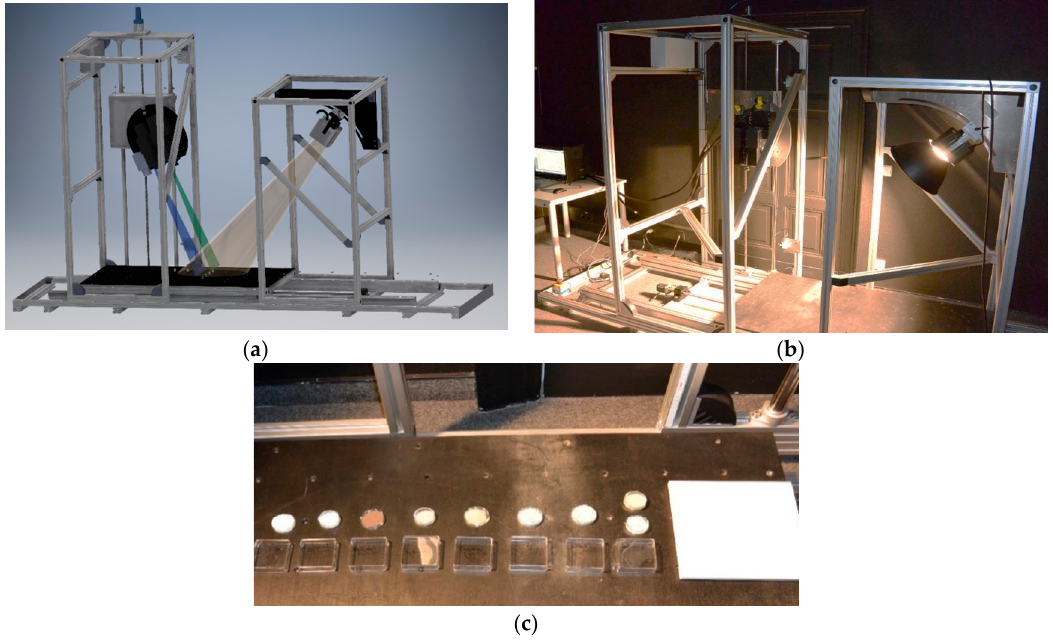
Figure 1. Translational imaging spectroscopy in the laboratory and the ( a ) CAD model, ( b ) experimental setup and ( c ) arrangement of the samples.